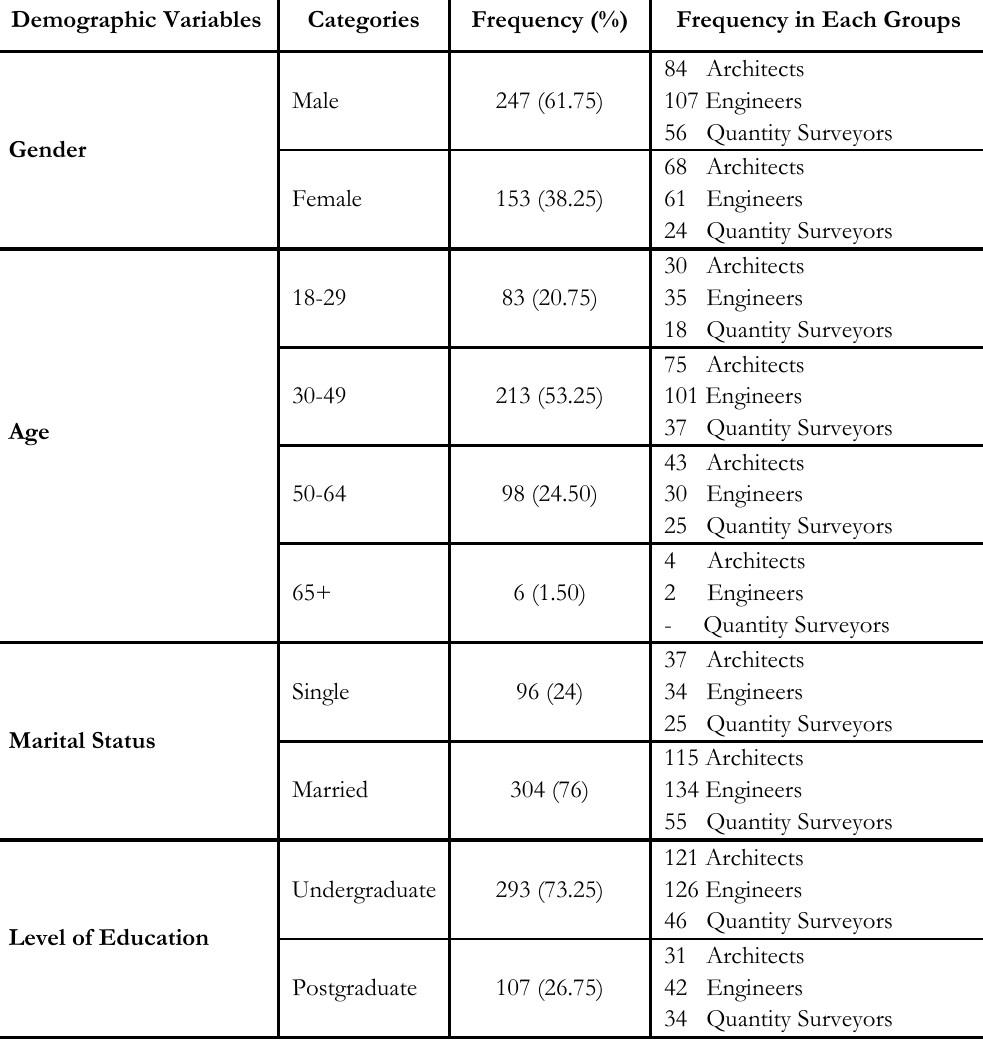
Table 2: Demographic information Demographic